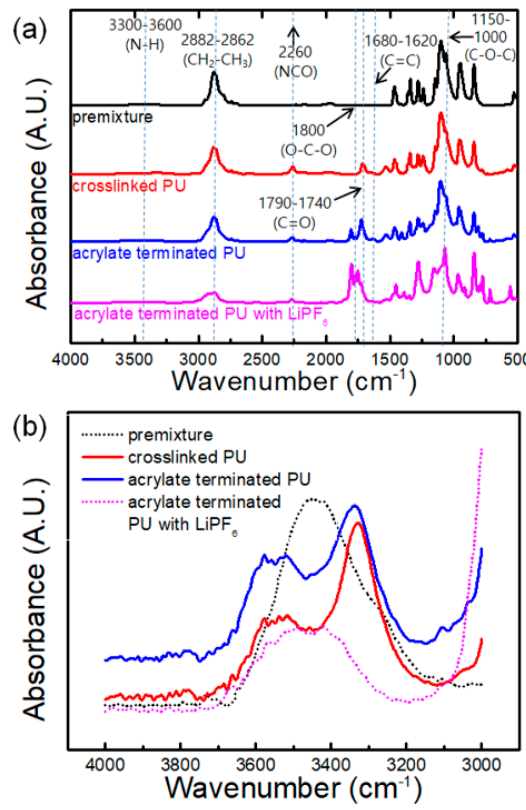
Figure 2. FTIR spectra of the polyurethane (PU) prepolymers at ( a ) 4000–500 and ( b ) 4000–3000 cm − 1 .